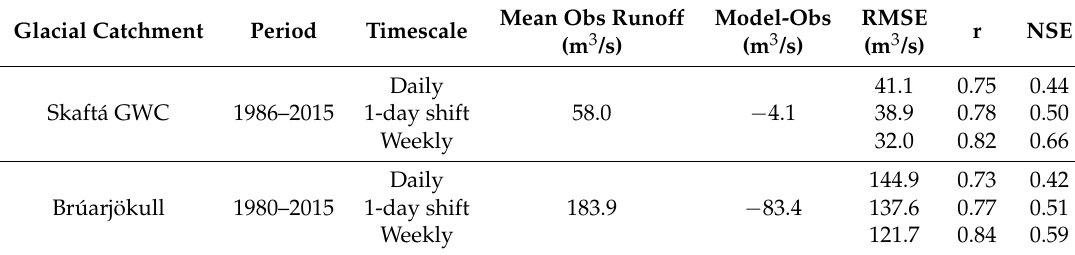
Table 4. Comparison statistics of the runoff (April–October) from Skaftá GWC into Skaftá river and from Brúarjökull into Jökulsá á Dal river at Hjarðarhagi (1980–2007) and Hálslón reservoir (2007–2015) according to observations and the simulation. The mean difference, RMSE, correlation, and Nash–Sutcliffe model efficiency coefficient are given. The RMSE, correlation, and NSE are calculated both for daily means, daily means with a model shift of one day, and weekly